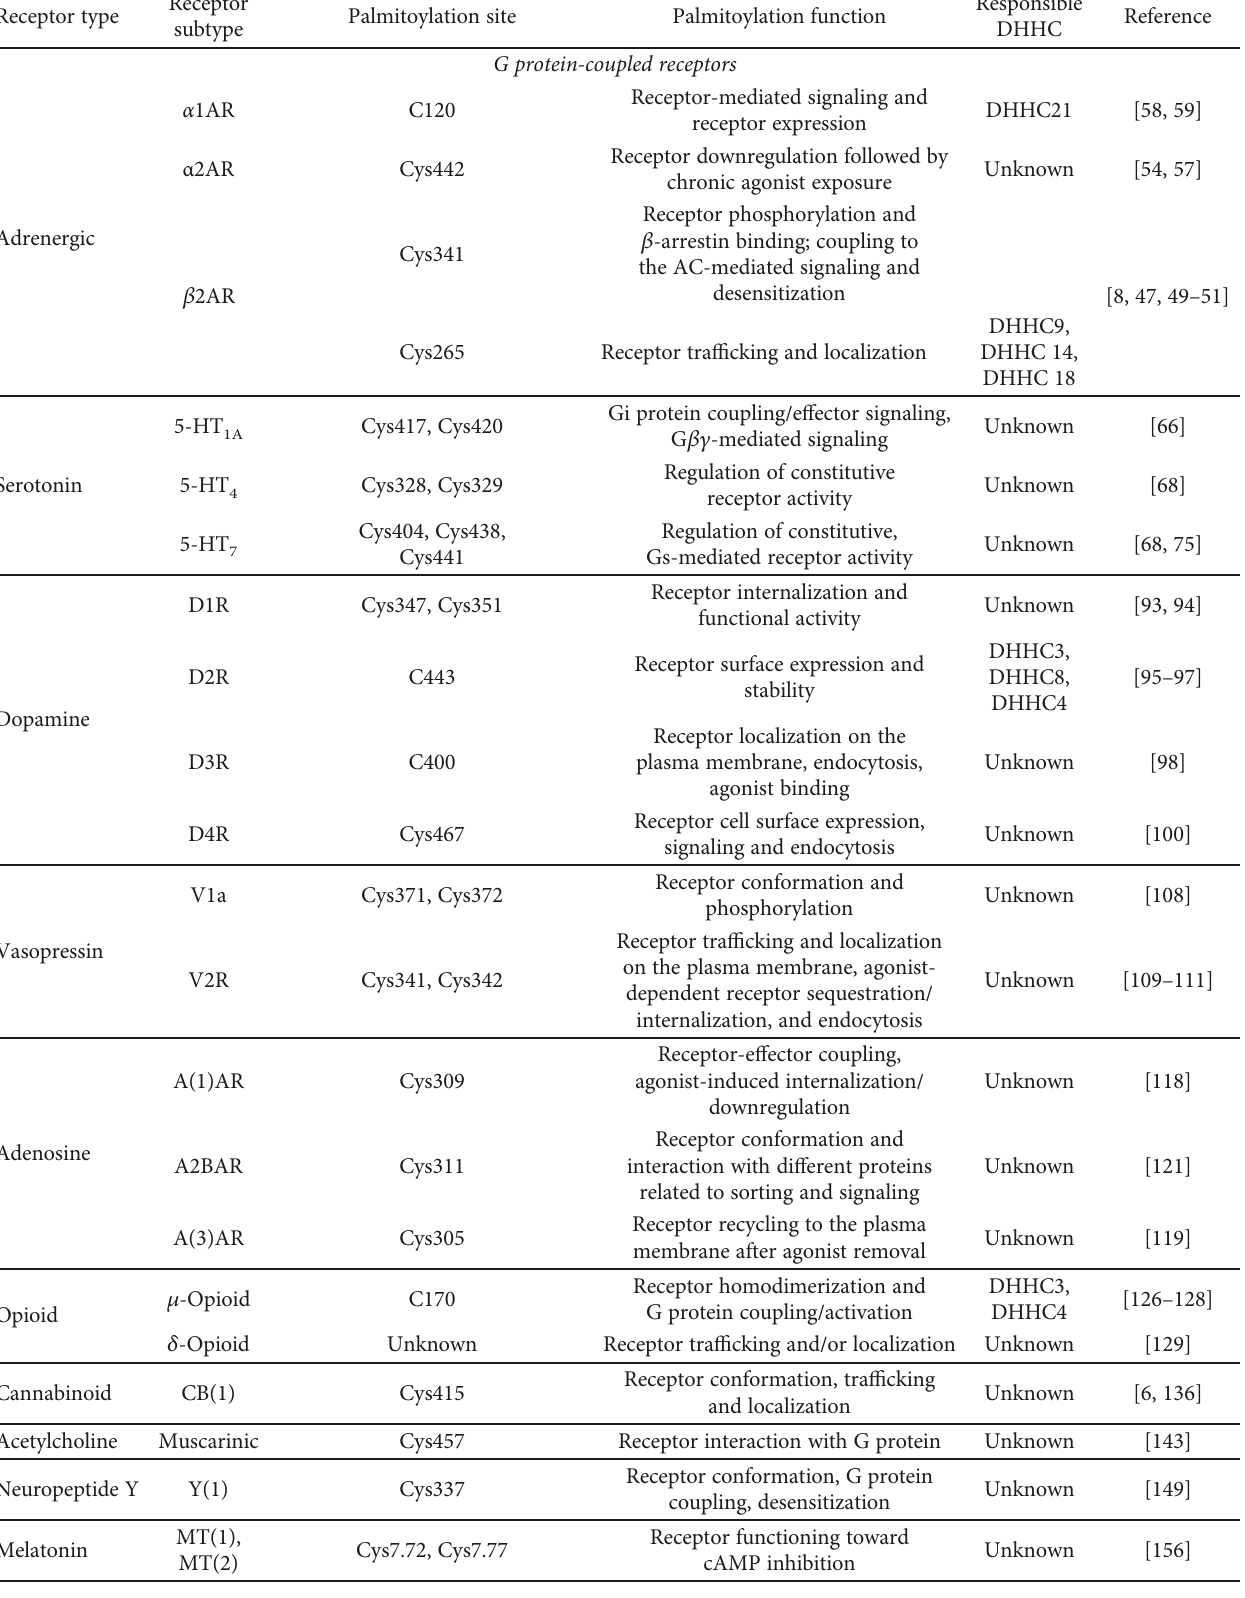
Table 1: Palmitoylation sites and functions of neurotransmitter receptor